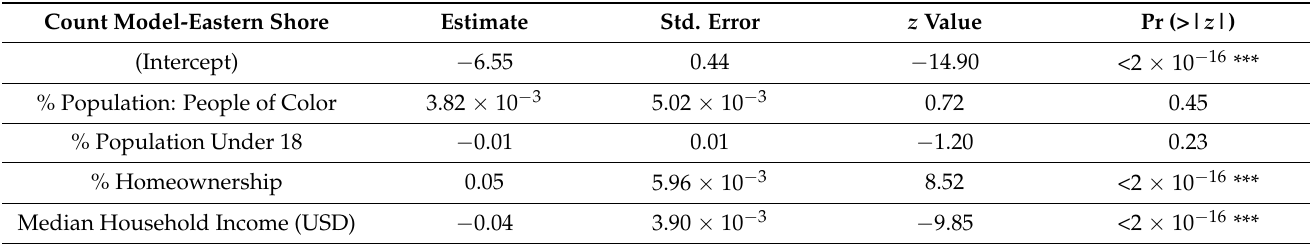
Table 5. Zero-inflated Poisson Regression Modeling for MD Chicken CAFOs in the Eastern